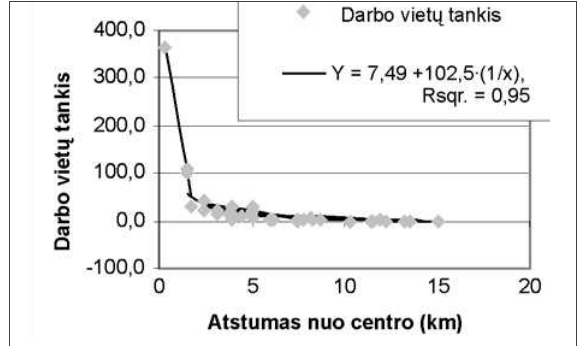
Fig 1. Inverse regression function connects density of working places and distance from the city center